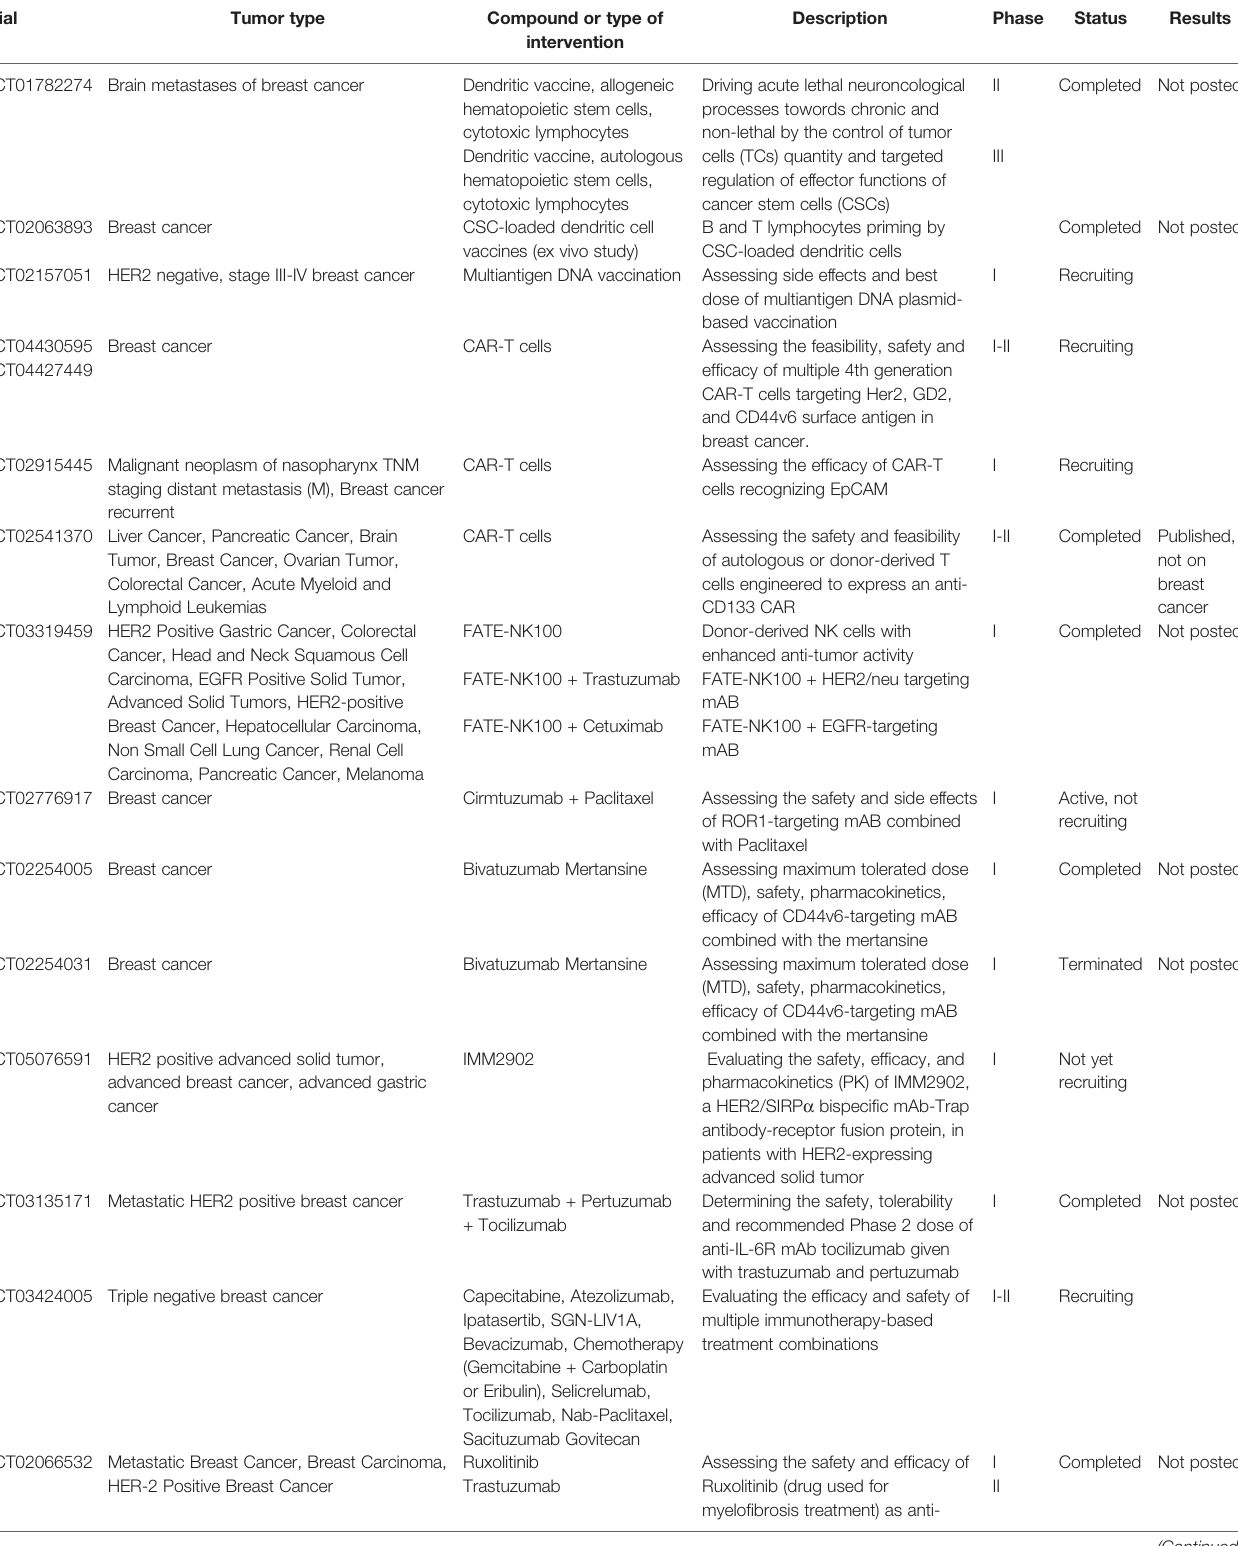
TABLE 1 | Clinical trials on breast cancer stem cell